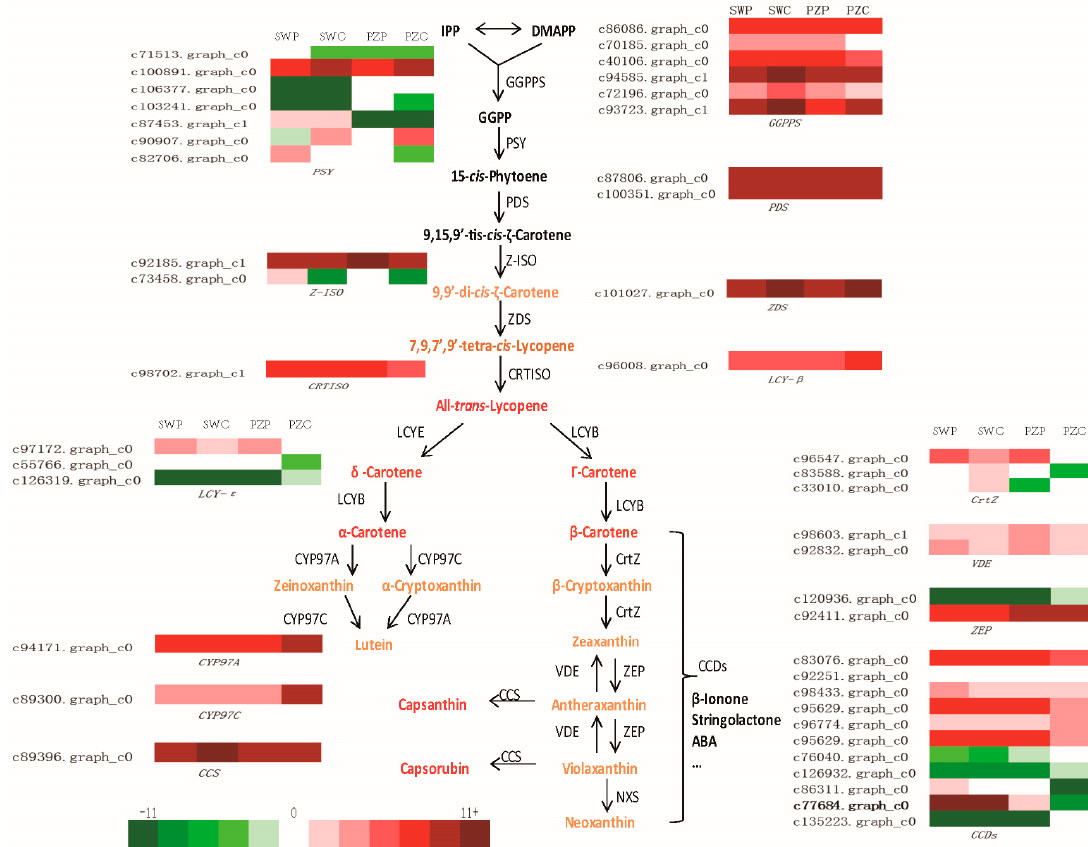
Figure 4. The carotenoid biosynthesis process with its core metabolites and enzymes and the expression levels of core enzyme genes. Enzyme names and expression patterns are indicated at the side of each step. Metabolites are bolded and colored according to their compound colors, and black indicates no color. Color boxes from left to right represent unigenes showing lower or higher expression level in perianth of Slim Whitman (SWP), coronas of Slim Whitman (SWC), perianth of ‘Pinza’ (PZP), and corona of ‘Pinza’ (PZC), respectively. Color saturation represents magnitude of log 2 (expression ratio) for each unigenes, with the FPKM values 0–0.0019, 0.0019–0.008, 0.008–0.03125, 0.03125–0.125, 0.125–0.5, 0.5–2, 2–8, 8–32, 32–128, 128–512, 512–2048, and ≥ 2048 represented by scale levels − 11 to 11, respectively.